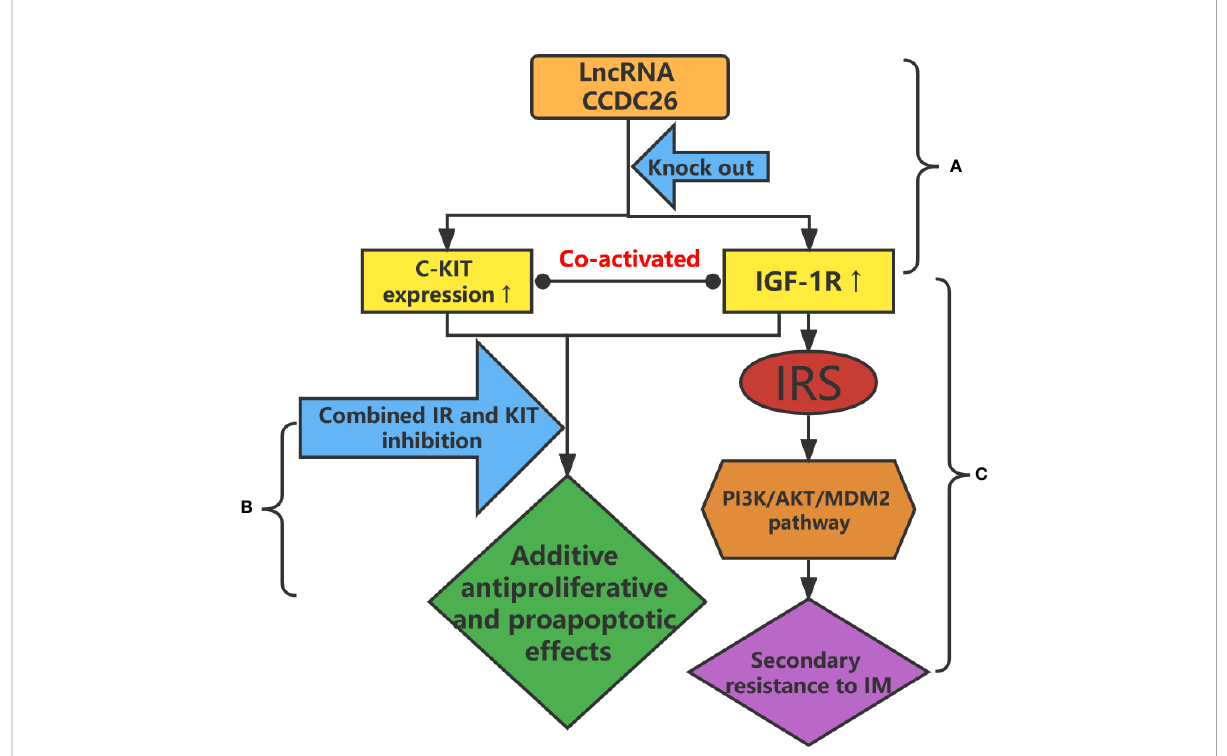
FIGURE 2 (A) CCDC26 knockout upregulates the expression of C-KIT and IGF-1R in IM-resistant GISTs. (B) Additive antiproliferative and proapoptotic effects are obtained after the combined inhibition of IR and KIT in IM-resistant GIST cells. (C) Upregulation of IGF-1R leads to drug resistance through the PI3K/AKT/MDM2 signaling